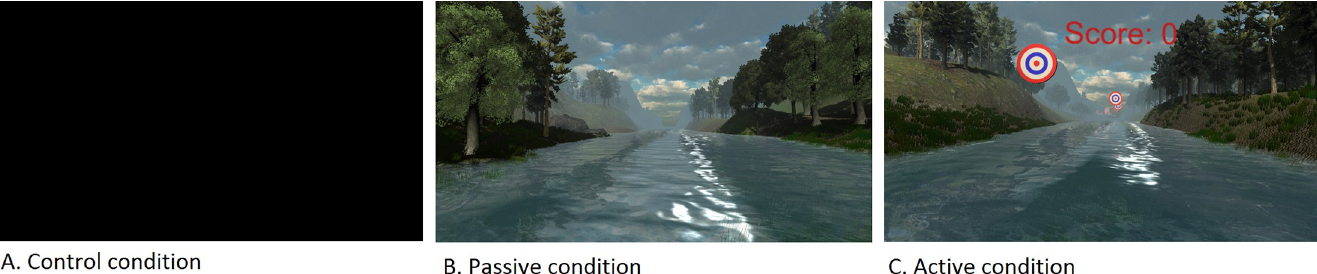
Fig 1. Screenshots of the Virtual Reality (VR) conditions: A = control condition, B = passive condition, C = active condition.